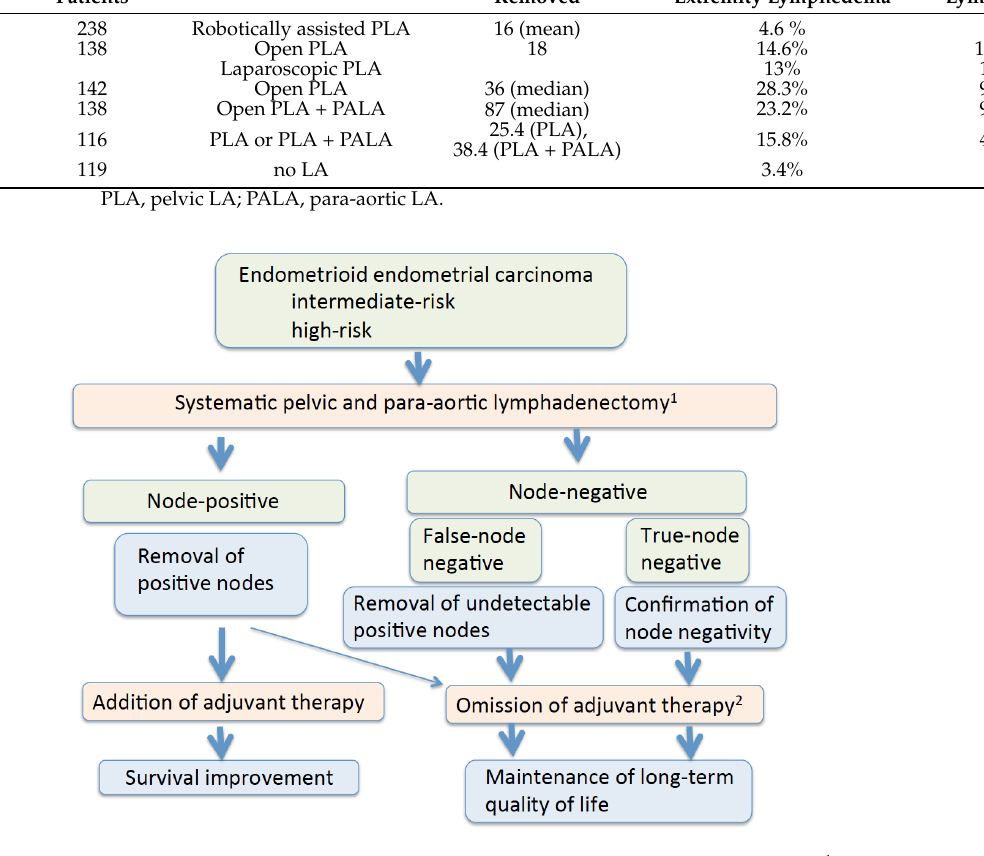
Figure 1. Possible therapeutic benefits of systematic lymphadenectomy. 1 Lymphadenectomy may cause surgical morbidity and lymphedema. 2 Omission of adjuvant therapy may be possible in patients with node-negative uterine-confined disease and patients with isolated tumor cells.